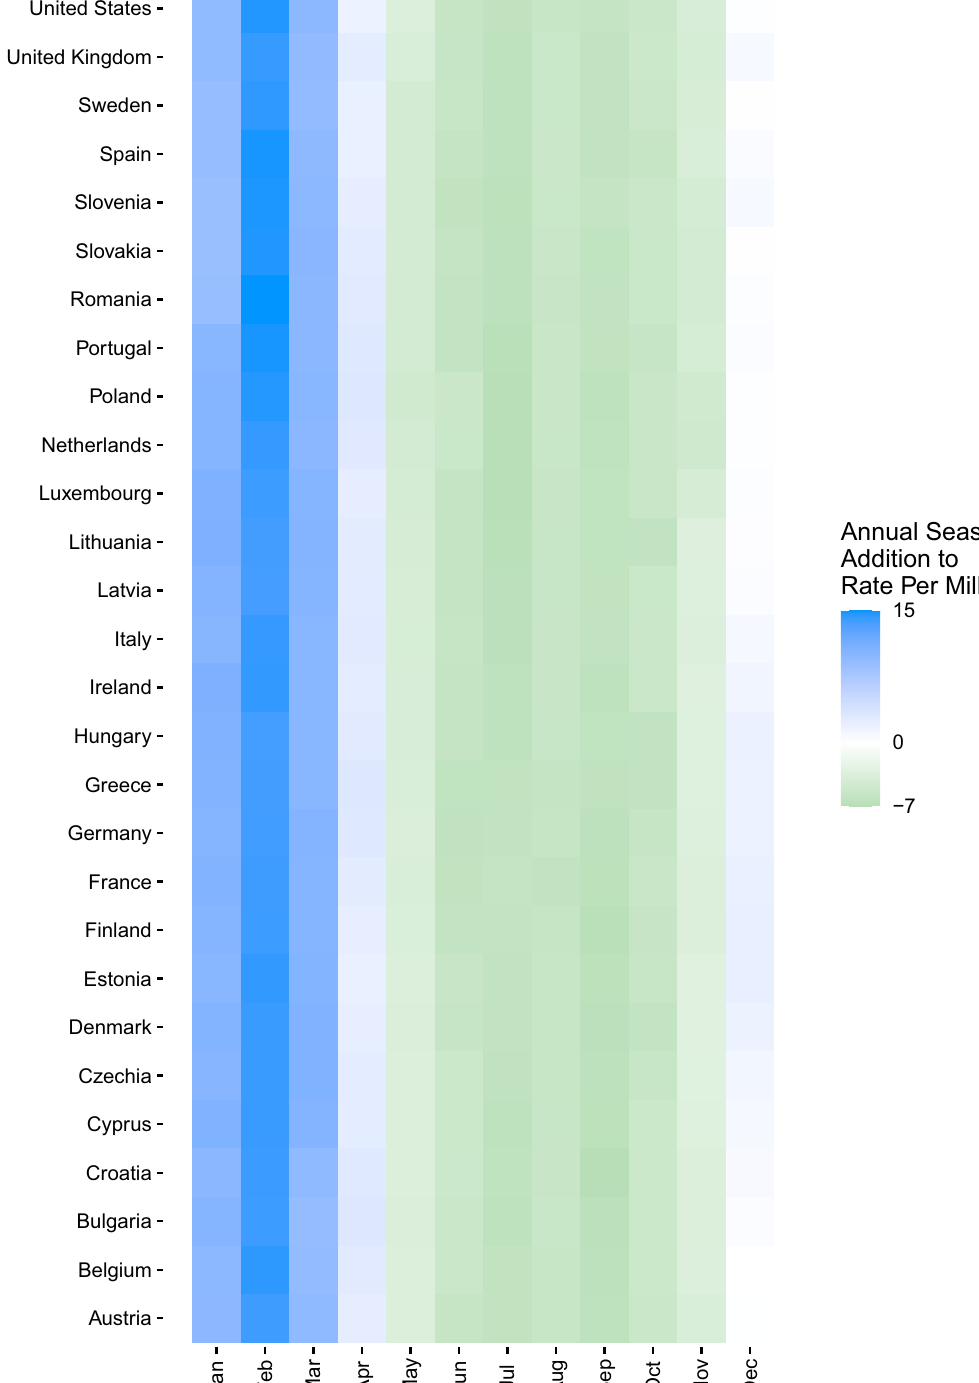
Figure 2. Heatmap of the influenza percent positivity median annual seasonal component by month, Oct 2009 through Dec 2021. Data Source: World Health Organization 25